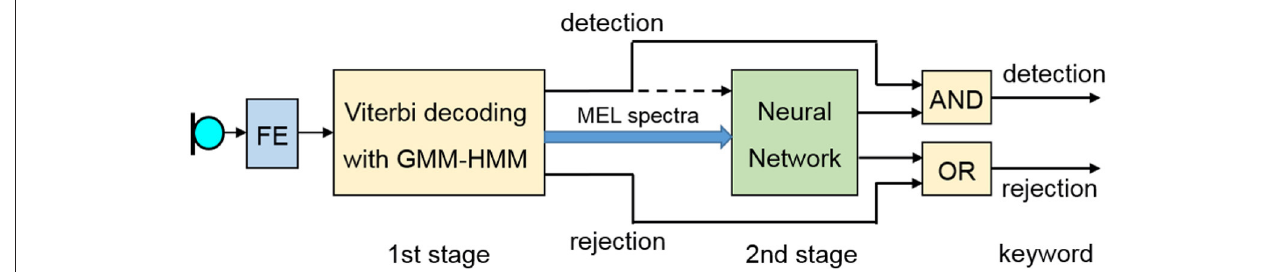
FIGURE 4 | Two-stage keyword recognition (FE, feature extraction).